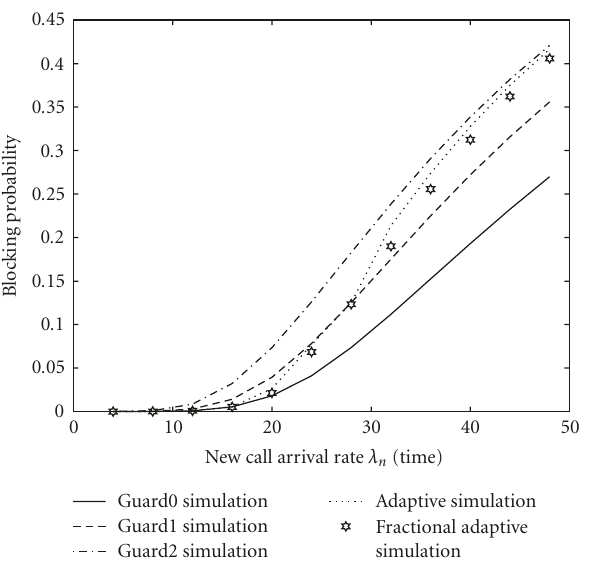
Figure 9: Simulation results of hando ff call failure probability for nineteen-cell wrap around